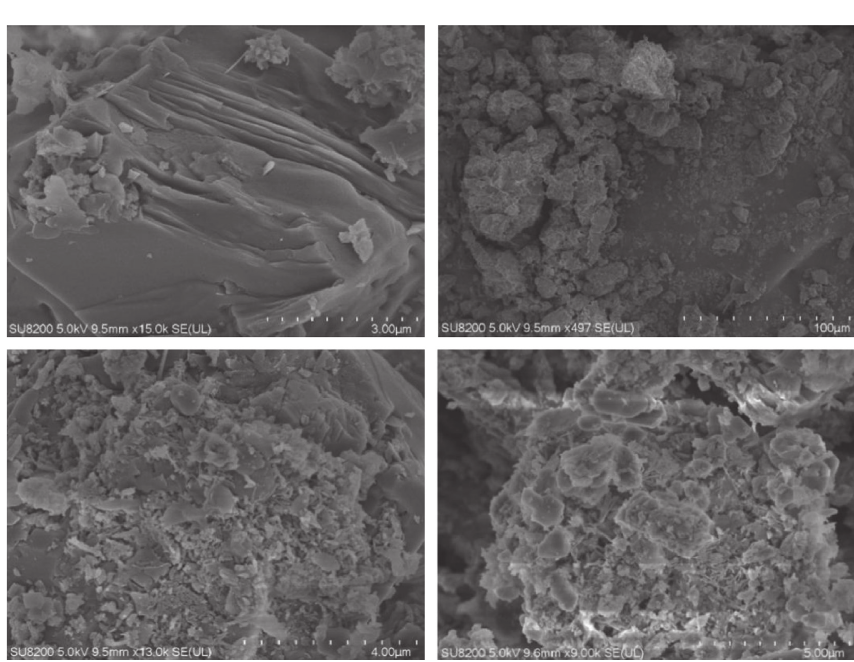
Figure 11: Microstructure of Group